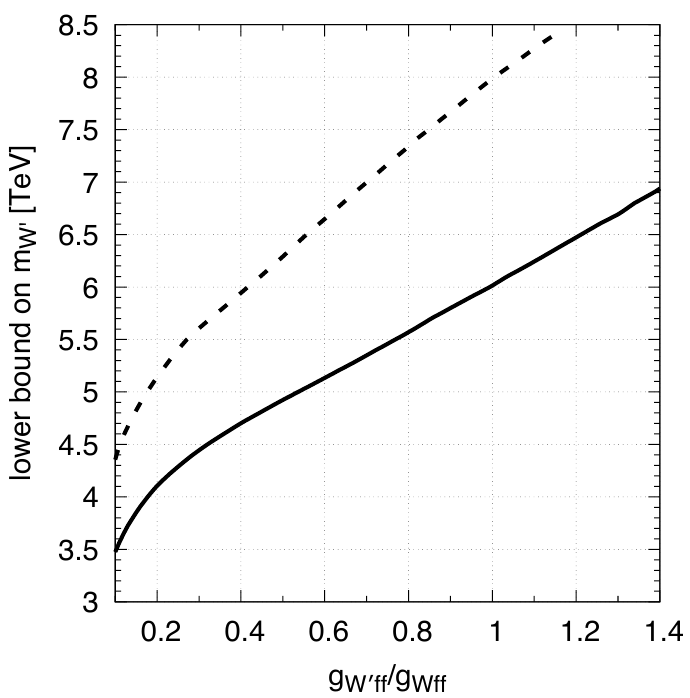
coupling obtained L f L